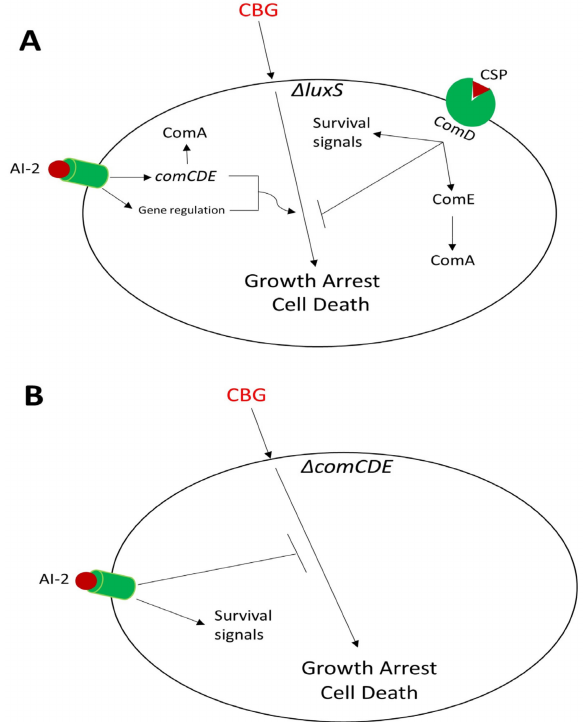
Figure 12. ( A , B ). The prevention and promotion of the anti-bacterial effect of CBG by the autoinducers 21-CSP and AI-2 in ∆ luxS ( A ) and ∆ comCDE ( B ) S. mutant strains. In the ∆ luxS strain, 21-CSP prevents, while AI-2 enhances the anti-bacterial effect of CBG. In the ∆ comCDE strain, AI-2 prevents the anti- bacterial effect of